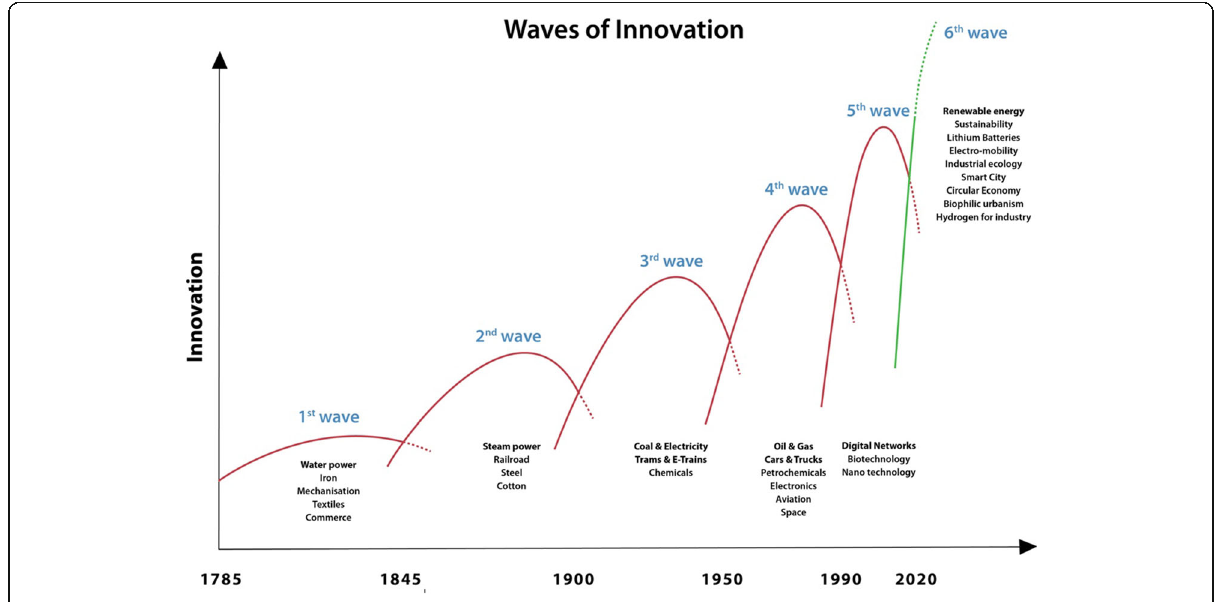
Fig. 9 Innovation waves and transitions to new economic systems. Source